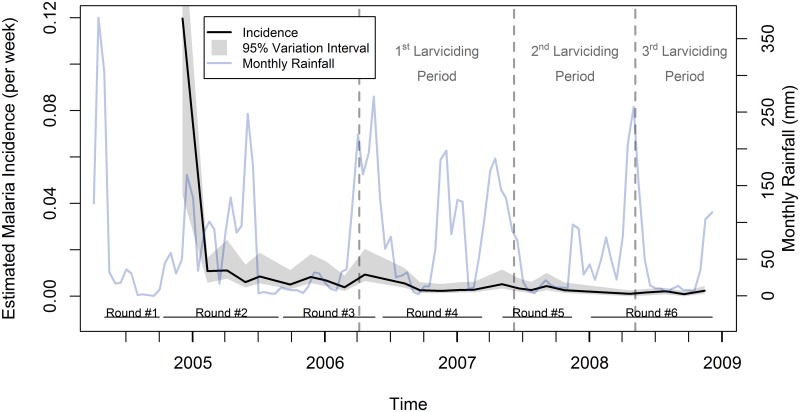
Estimated incidence rates, variability intervals, and 1-month lagged rainfall by stages of the survey rounds.Variability intervals consider the uncertainty due to sampling and partial identifiability of the mixture model. For ease of visualization, the variability interval for the first point in the graph was truncated. Each survey round of the UMCP conducted interviews in three wards at a time, or stages. Thus, each round had five stages in order to cover all 15 wards. Rainfall estimates were obtained from the National Oceanic and Atmospheric (NOAA) Climate Prediction Center (CPC), have a spatial resolution of eight kilometers [35], and were lagged by 30 days.